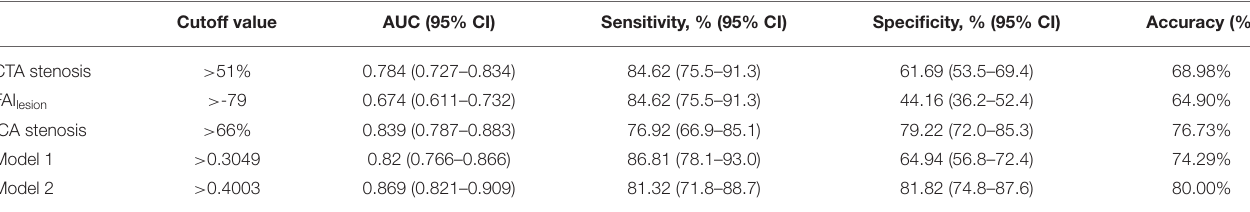
TABLE 4 | Diagnostic performance of coronary computed tomography angiography (CCTA)-derived parameters for predicting functional ischemic stenosis when using best cutoff